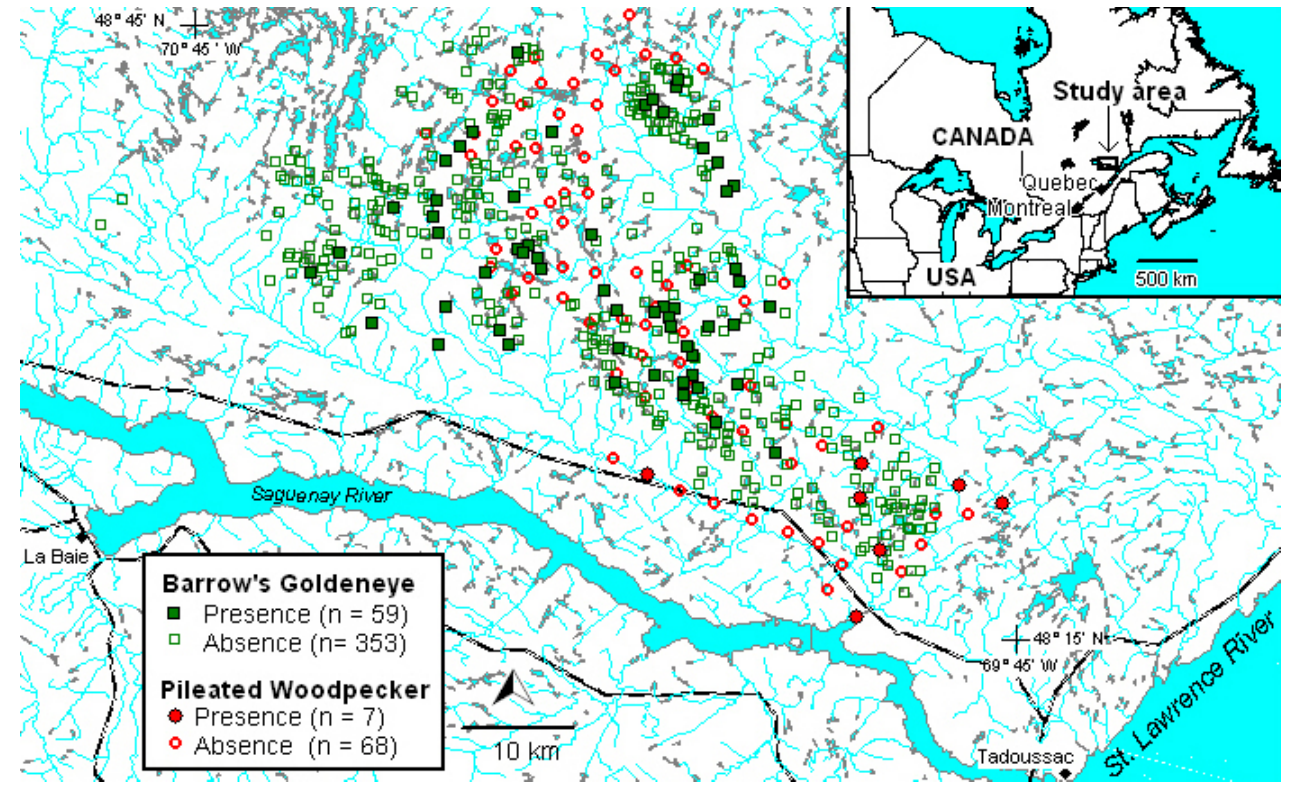
Fig. 1 . Pileated Woodpecker ( Dryocopus pileatus ) occurrence at 75 playback stations during May and June 2005 and lakes at which Barrow’s Goldeneyes ( Bucephalus islandica ) were observed according to a helicopter survey conducted in May 2001 by the Canadian Wildlife Service over 412 lakes in the study area. This figure shows that these two species are not sympatric in the study